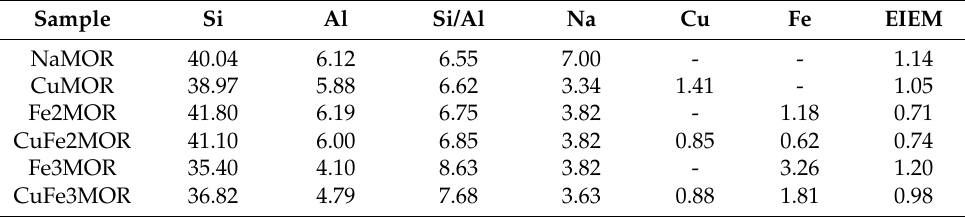
Table 2. Element composition and EIEM for the studied samples determined by